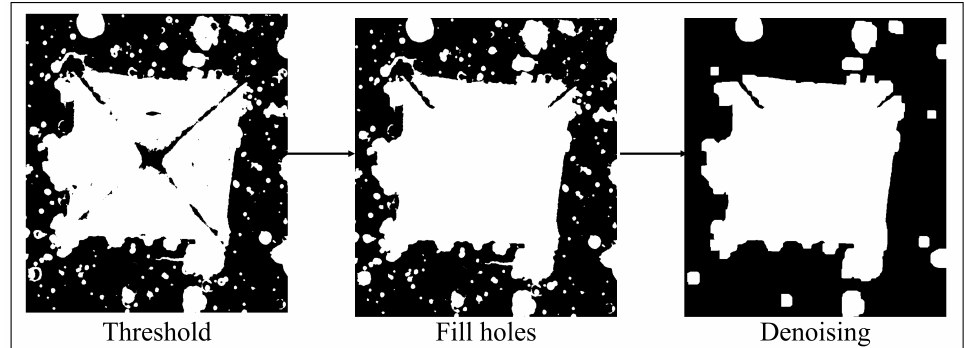
Figure 7. Thresholding, fill holes, and denoising.